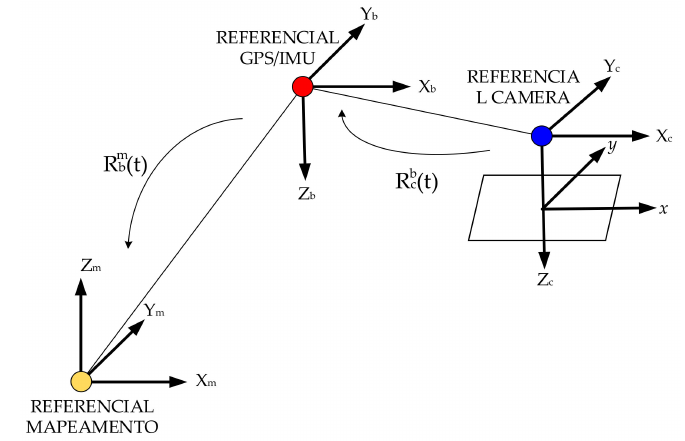
Figure 7. Coordinate transformation for direct